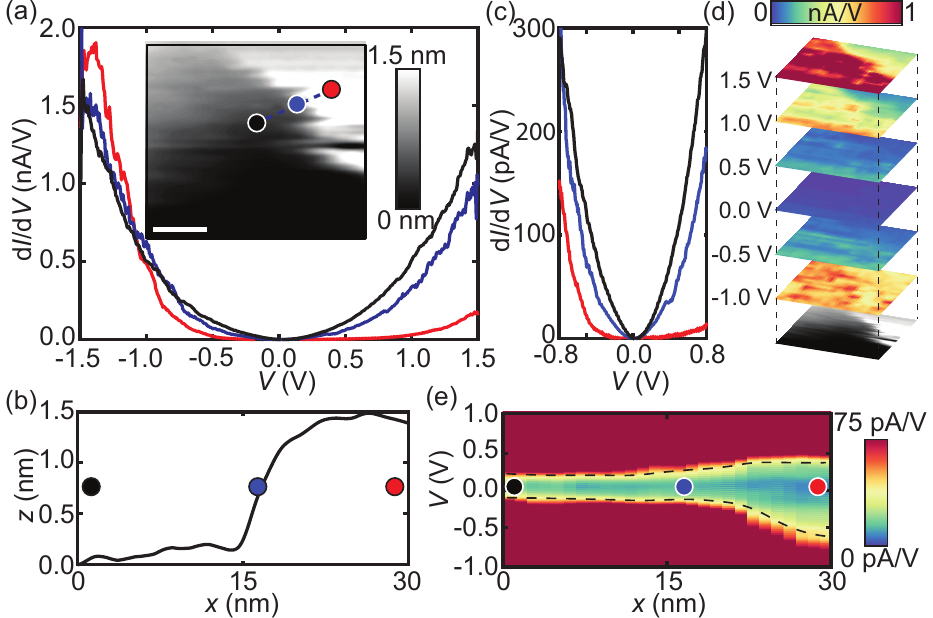
( V ) ) on the 10-unit-cell-thick BBO film on Nb:STO, Figure 3. ( a ) Differential conductivity spectra ( d I d V the curve colors correspond to the positions (colored dots) marked in the inset. A wide bandgap (red) to small bandgap (black) transition is found depending on the thickness of the film. Inset: Topography image (100 × 100 nm, scale bar 25 nm) with spectrum locations marked by the colored dots. The tunneling parameters are 700 pA and − 1.5 V. ( b ) Cross-sectional height profile, from the corresponding blue dashed line in the inset of ( a ), showing a height difference of 1.5 nm between the higher and lower region. ( c ) Zoom-in of the spectroscopy data of ( a ) revealing a decrease of the bandgap when moving from the higher to the lower region. ( d ) d I /d V maps at different bias voltage set points. The lateral position is aligned with the topography image at the bottom, which is the same as the inset in ( a ). An increased local density of states (LDOS) at the lower region of the sample is ( V ) cross-section recorded across a transition region (colored dots clearly visible for V > 1 V . ( e ) d I d V correspond to the dots in the inset of ( a )). A strong decrease of the bandgap is observed when going from the higher (red dot) to the lower (black dot) region. The black dashed line is a guide to the